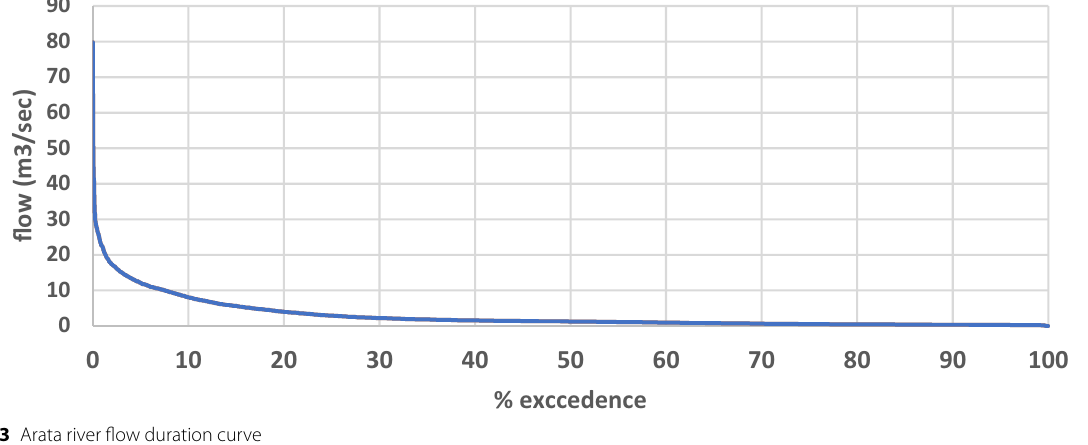
Fig. 13 Arata river flow duration curve